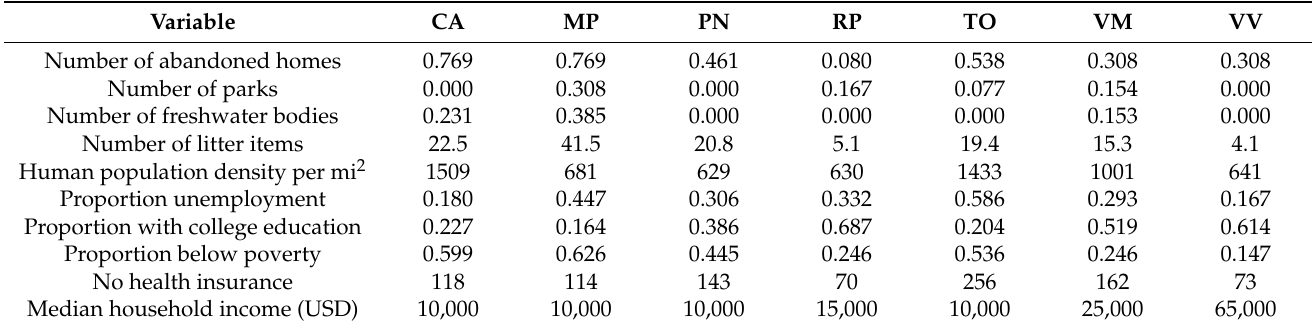
Table 1. Socio-economic variables by neighborhood in the San Juan Metropolitan Area. Mean number of abandoned homes, parks, freshwater bodies, and litter items are mean values calculated from foot surveys ( n = 103) in October 2018, January 2019, and May 2019. The remainder of the variables are mean values calculated from the U.S. Census data (2018; n = 21). The neighborhood abbreviations are: CA—Cataño, MP—Martin Peña, PN—Puerto Nuevo, RP—R í o Piedras,